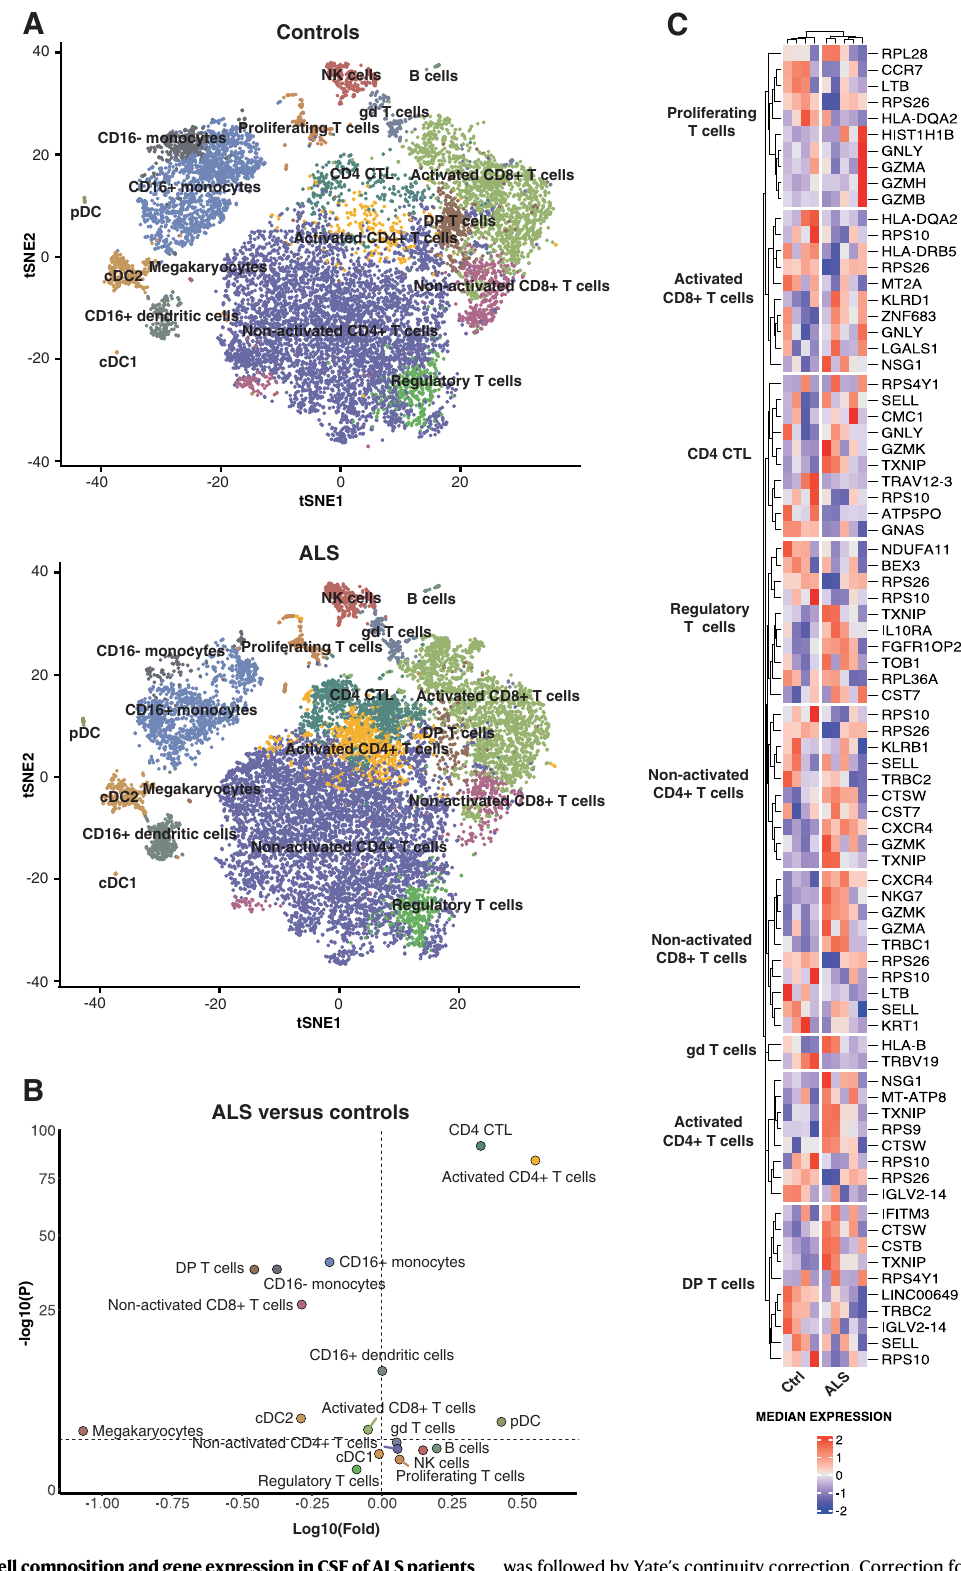
Fig.3|DifferentialcellcompositionandgeneexpressioninCSFofALSpatients versus controls. t-SNE plots of 10X scRNA-seq data showing leukocyte subsets from fi ve ALS patients and four controls ( A ). A pairwise comparison of ALS and controlsintermsofcellcountabundanceforeverycelltypewasperformedusinga two-sidedproportions z -test(horizontaldottedlinescorrespondto P